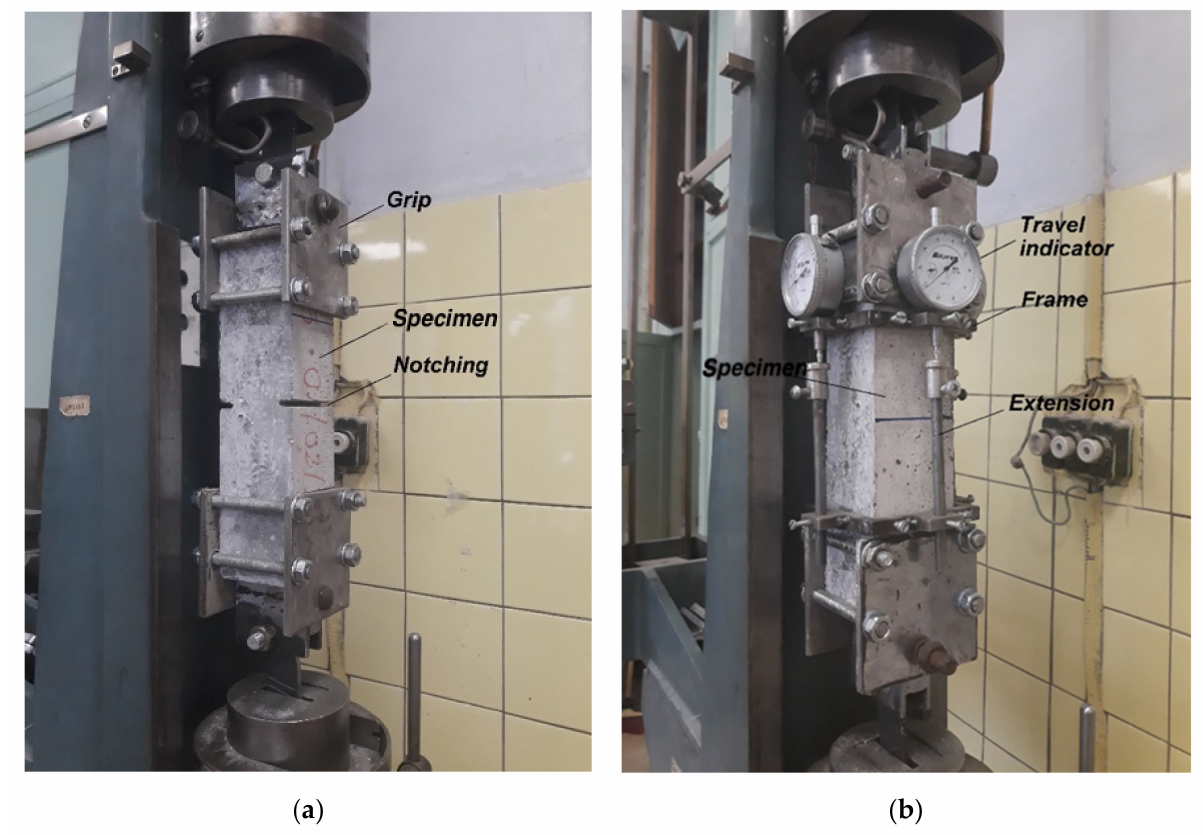
Figure 4. Testing Schemes. ( a ) For determination of tensile strength; ( b ) for determination of elastic